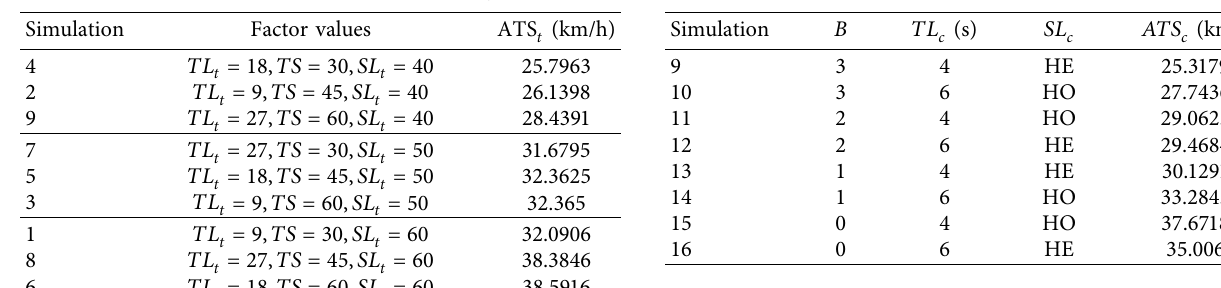
Table 9: Complementary simulations (experiment t .